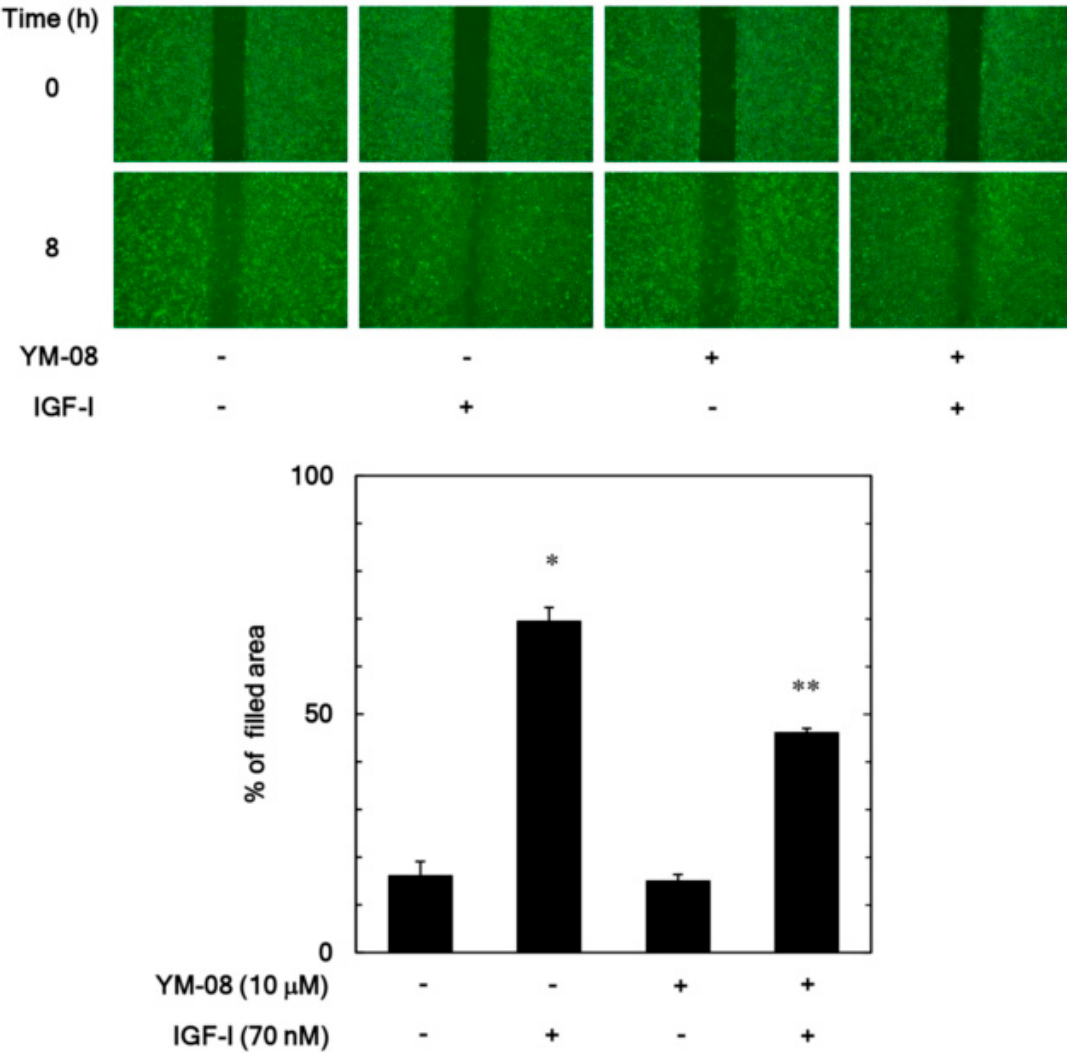
Figure 3. Effect of YM-08 on the IGF-I-induced migration of MC3T3-E1 cells. The migration was evaluated by a wound-healing assay. The cells were pretreated with 10 µM of YM-08 or vehicle for 60 min and then stimulated by 70 nM of IGF-I or vehicle for 8 h. The cells were photographed before IGF-I-stimulation (0 h) and after 8 h (upper panel, a representative result) and the area of migrated cells were measured (lower bar graph), which were obtained from triplicate independent experiments. * p < 0.05 compared to the value of the control cells without IGF-I stimulation. ** p < 0.05 compared to the value of IGF-I alone.